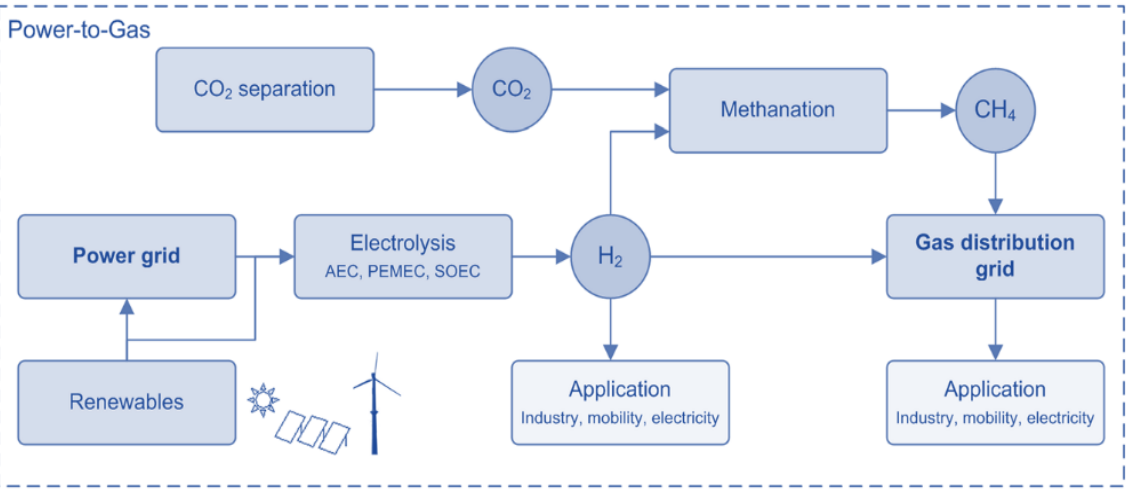
Figure 26. The power-to-gas concept. Reproduced with permission from Ref. [223]. Copyright© 2016, John Wiley and Sons.